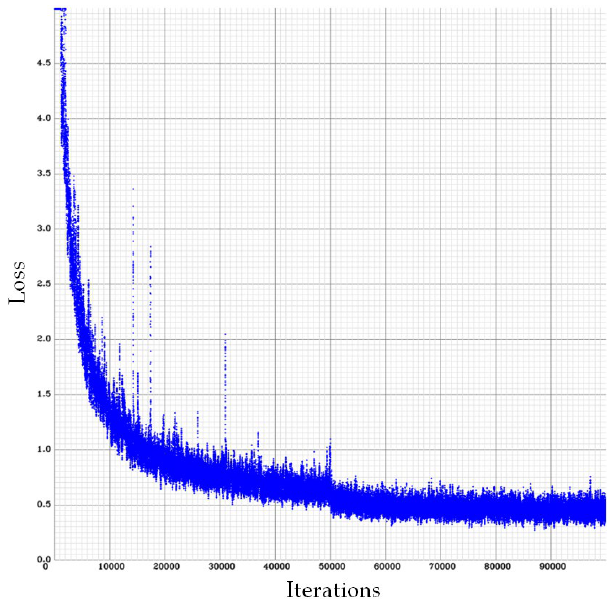
Figure 11. A chart of the loss function in the cell nucleus images trained by the YOLO algorithm (the number of iterations was 100,000, and the average loss was 0.3928).